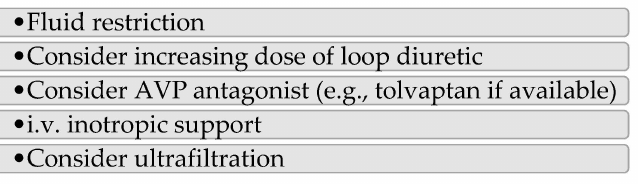
Figure 4. 2021 European Society of Cardiology Guidelines for the diagnosis and treatment of acute and chronic